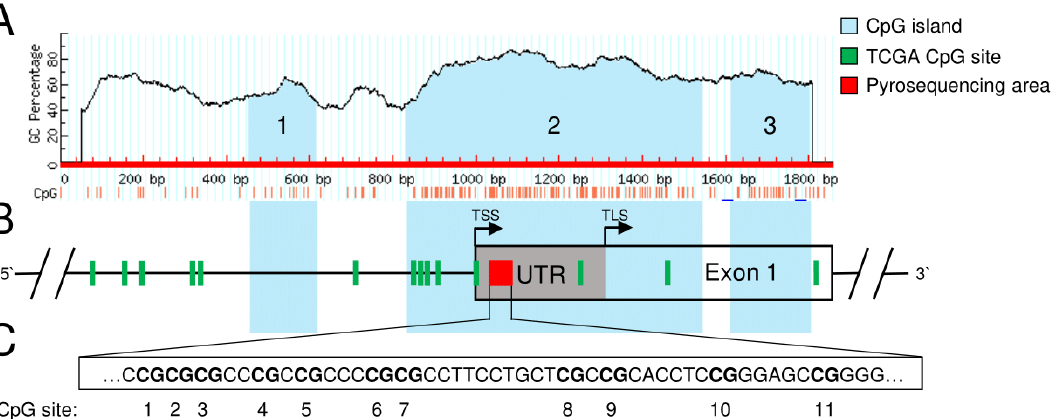
Figure 1. Localization of identified CpG islands and TCGA CpG sites in the region of interest of the genomic SFRP1 sequence (exon 1 and 1000 bp upstream). ( A ) Three identified CpG islands by default criteria of CpG island size > 100 bp, CG percentage > 50% and observed to expected CpG ratio > 60%. CpG islands are labelled in blue and numbered upstream to downstream (1–3) in the schematic SFRP1 gene map. ( B ) Additionally, positions of 14 CpG sites from the TCGA pancreatic cancer data set are labelled in green in the region of interest. Black line indicates promoter region upstream of transcription start site (TSS) as well as intronic sequence downstream of exon 1. The box indicates exon 1, including its grey marked 5 (cid:48) UTR (TLS denotes the translation start site). Note that seven CpG sites are covered by CGI2 (island 2 CpGs). The red box represents the area for methylation analysis, which is located in the 5 (cid:48) UTR of the first exon. ( C ) The area for methylation analysis (pyrosequencing assay) contains 11 selected CpG sites (numbered upstream to downstream,